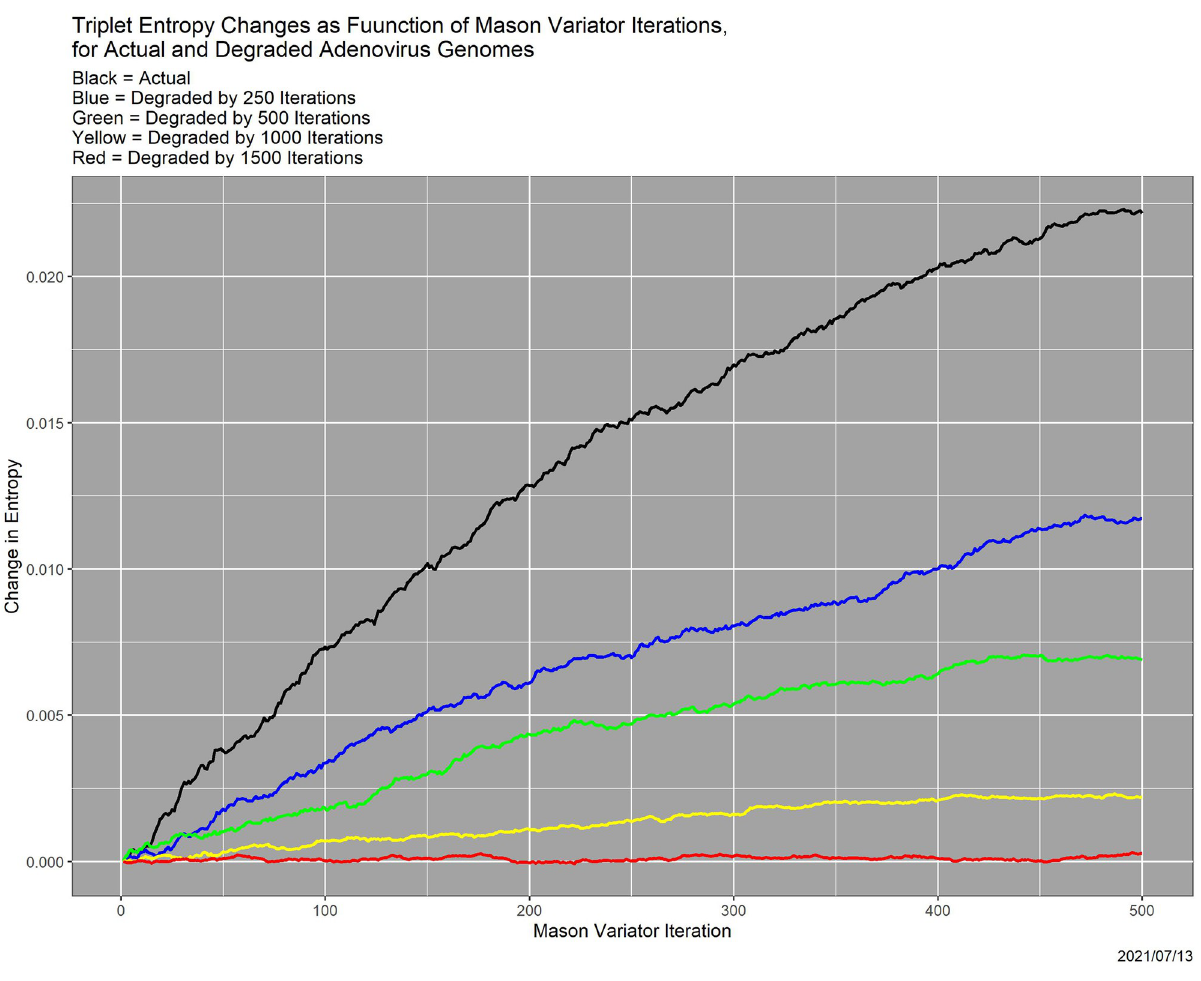
Fig 4. Change in entropy as a function of Mason_variator iterations, for one adenovirus genome and four degraded versions of it. Black : original genome; Blue : degraded by 250 iterations; Green : degraded by 500 iterations; Yellow : degraded by 1000 iterations; Red : degraded by 1500